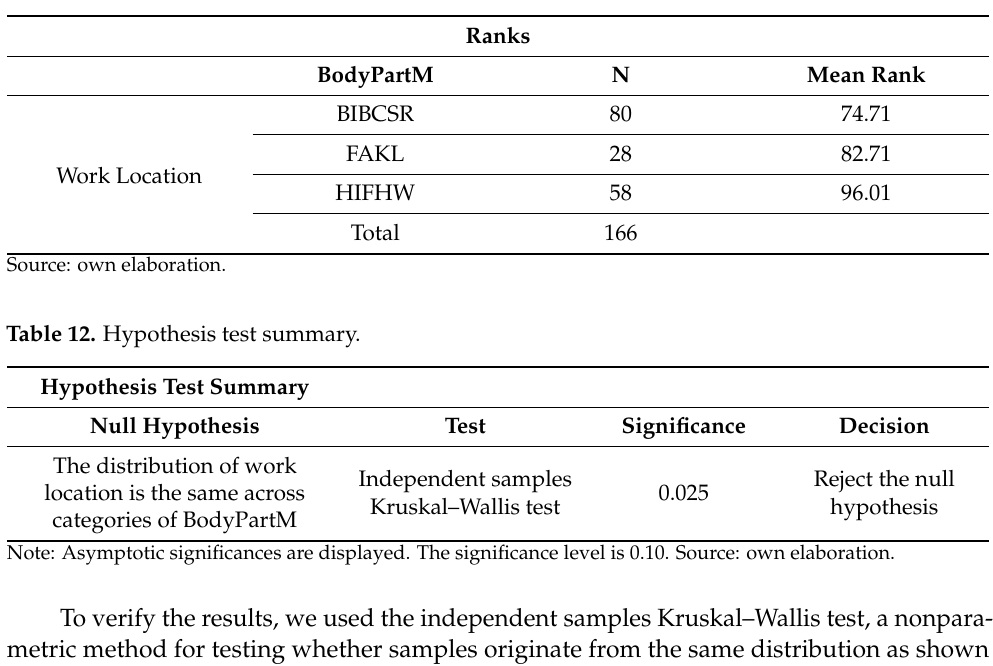
Table 11. Descriptive statistics: means.